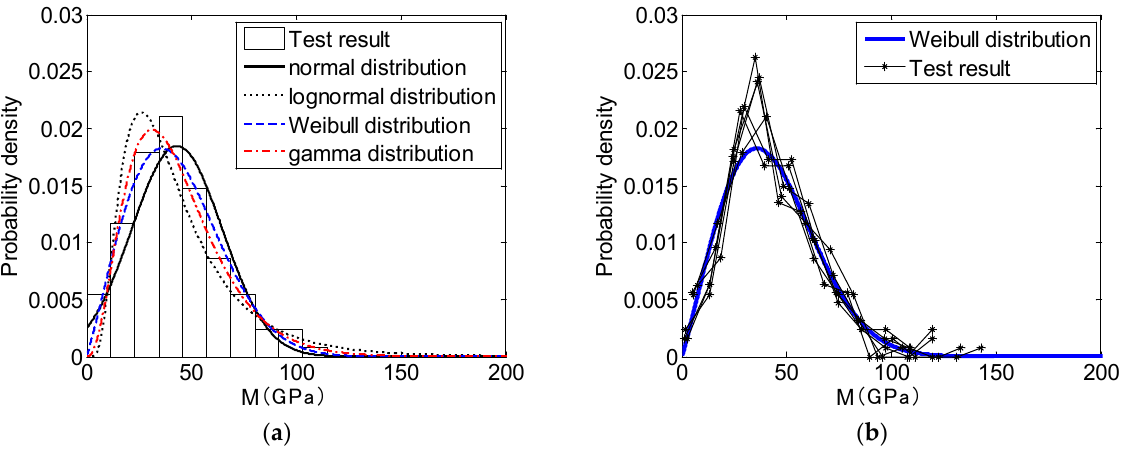
Figure 8. Frequency plots for indentation modulus of the ITZ: ( a ) histogram of one point out of six and 4 theoretical PDF curves; ( b ) frequency plots of 6 points and the theoretical PDF curve with best estimates.